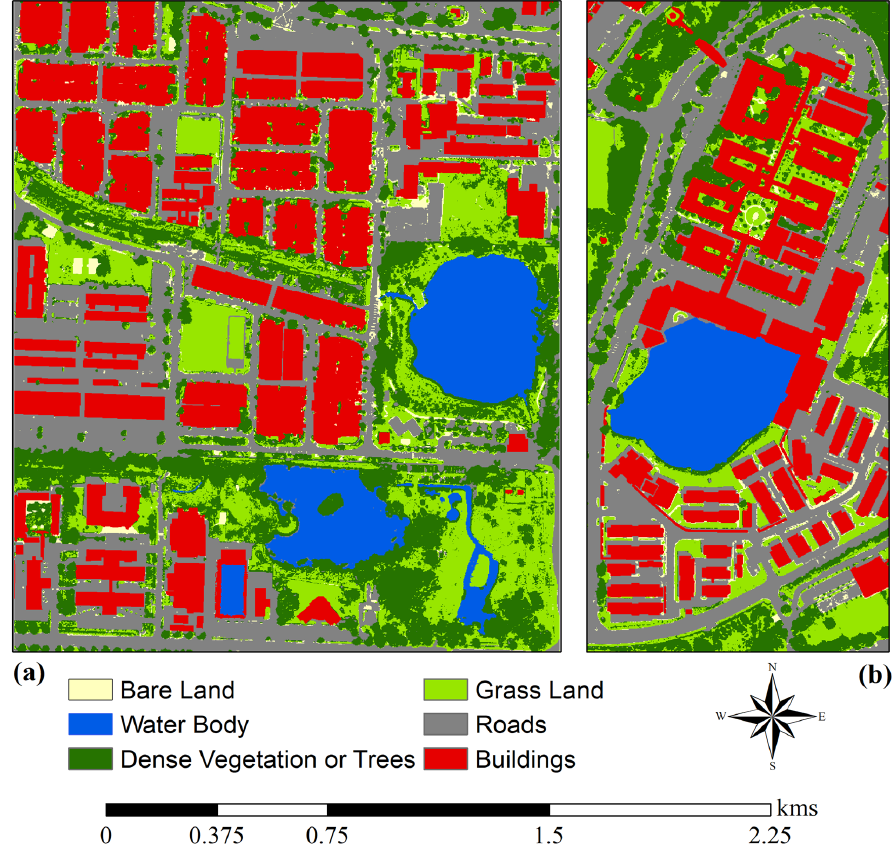
Figure 2. The ground truth data for the training and test areas. ( b ) represents the testing